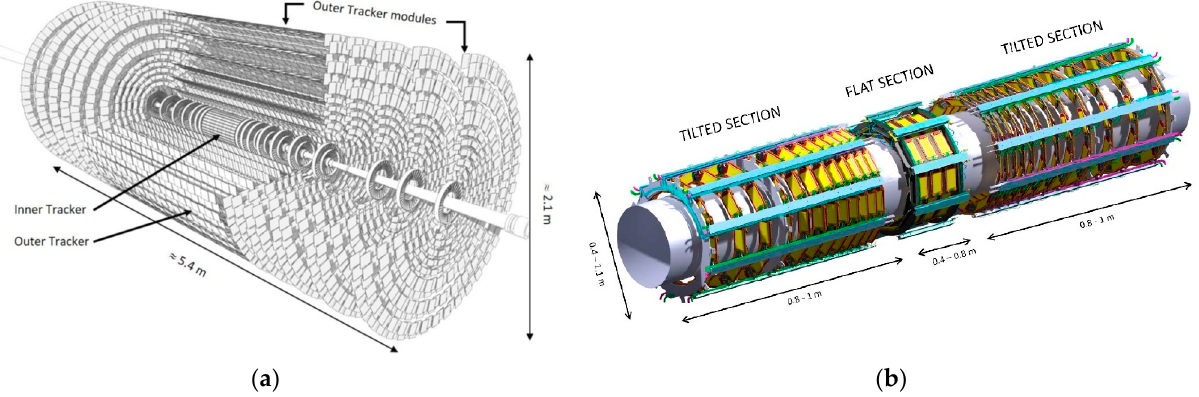
Figure 1. ( a ) Perspective view of the new Outer and Inner Trackers for CMS. The small rectangles that populate the disks at the ends and the concentric cylinders at the centre of the structure are the modules of the tracker. The cylinders are referred to as the barrel part of the tracker. ( b ) The inner- most layer of the Outer Tracker barrel section is subdivided into a central section (flat) and two tilted sections at both ends (from [4]). The yellow rectangles in the figures are the silicon sensor modules, horizontal (tilted) in the central (end) sections. The central part of the Inner Tracker support tube is also visible inside.